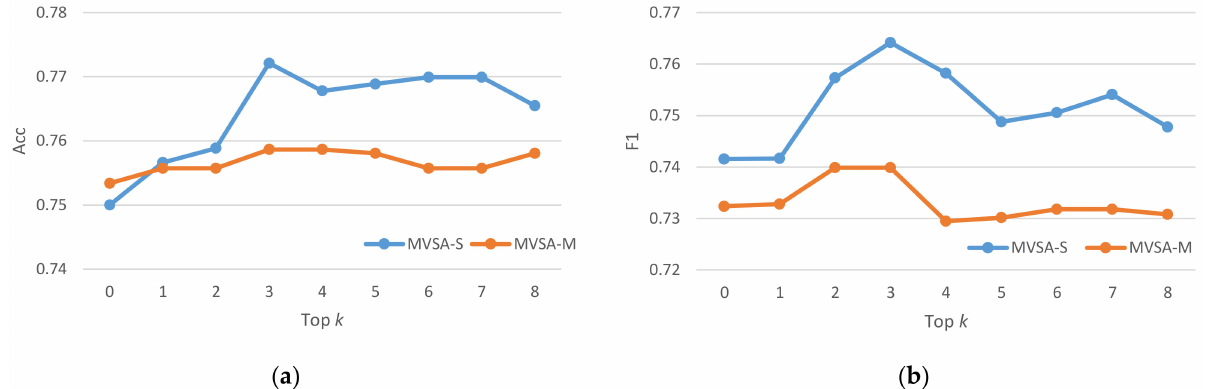
Figure 4. The experimental results for different values of hyperparameter k . ( a ) The accuracy of GLFN with different top k . ( b ) The F1-score of GLFN with different top k .